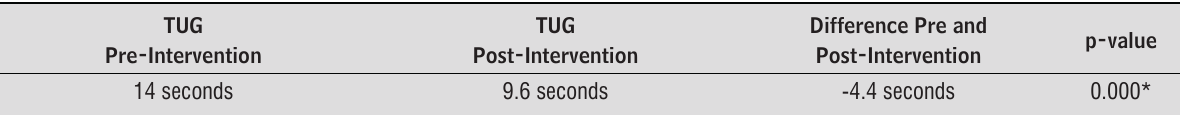
Table 3 - Outcomes of TUG test related to pre- and post-intervention in elderly participating in interaction groups in Caxias do Sul City, RS State, 2011